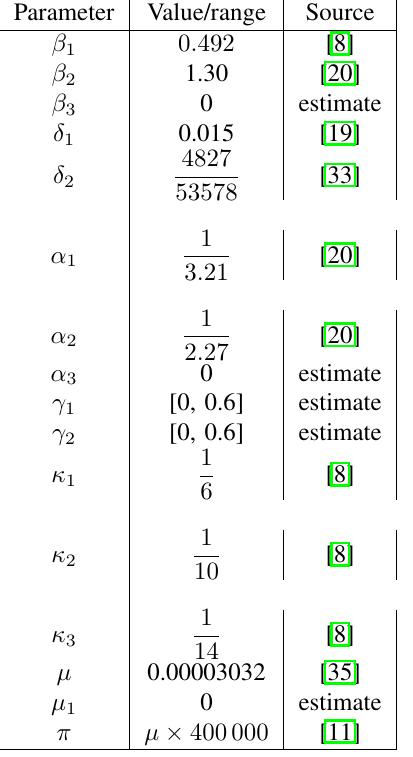
TABLE I: Numerical values for the parameters of the Italian